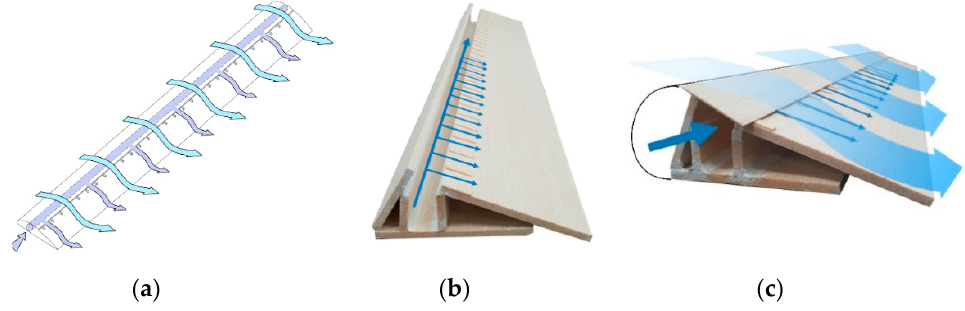
Figure 10. Internal shape of the airfoil and the corresponding air flow patterns. ( a ) Overview of airflow, ( b ) Airflow inside the louver, ( c ) Airflow on the louver surface.